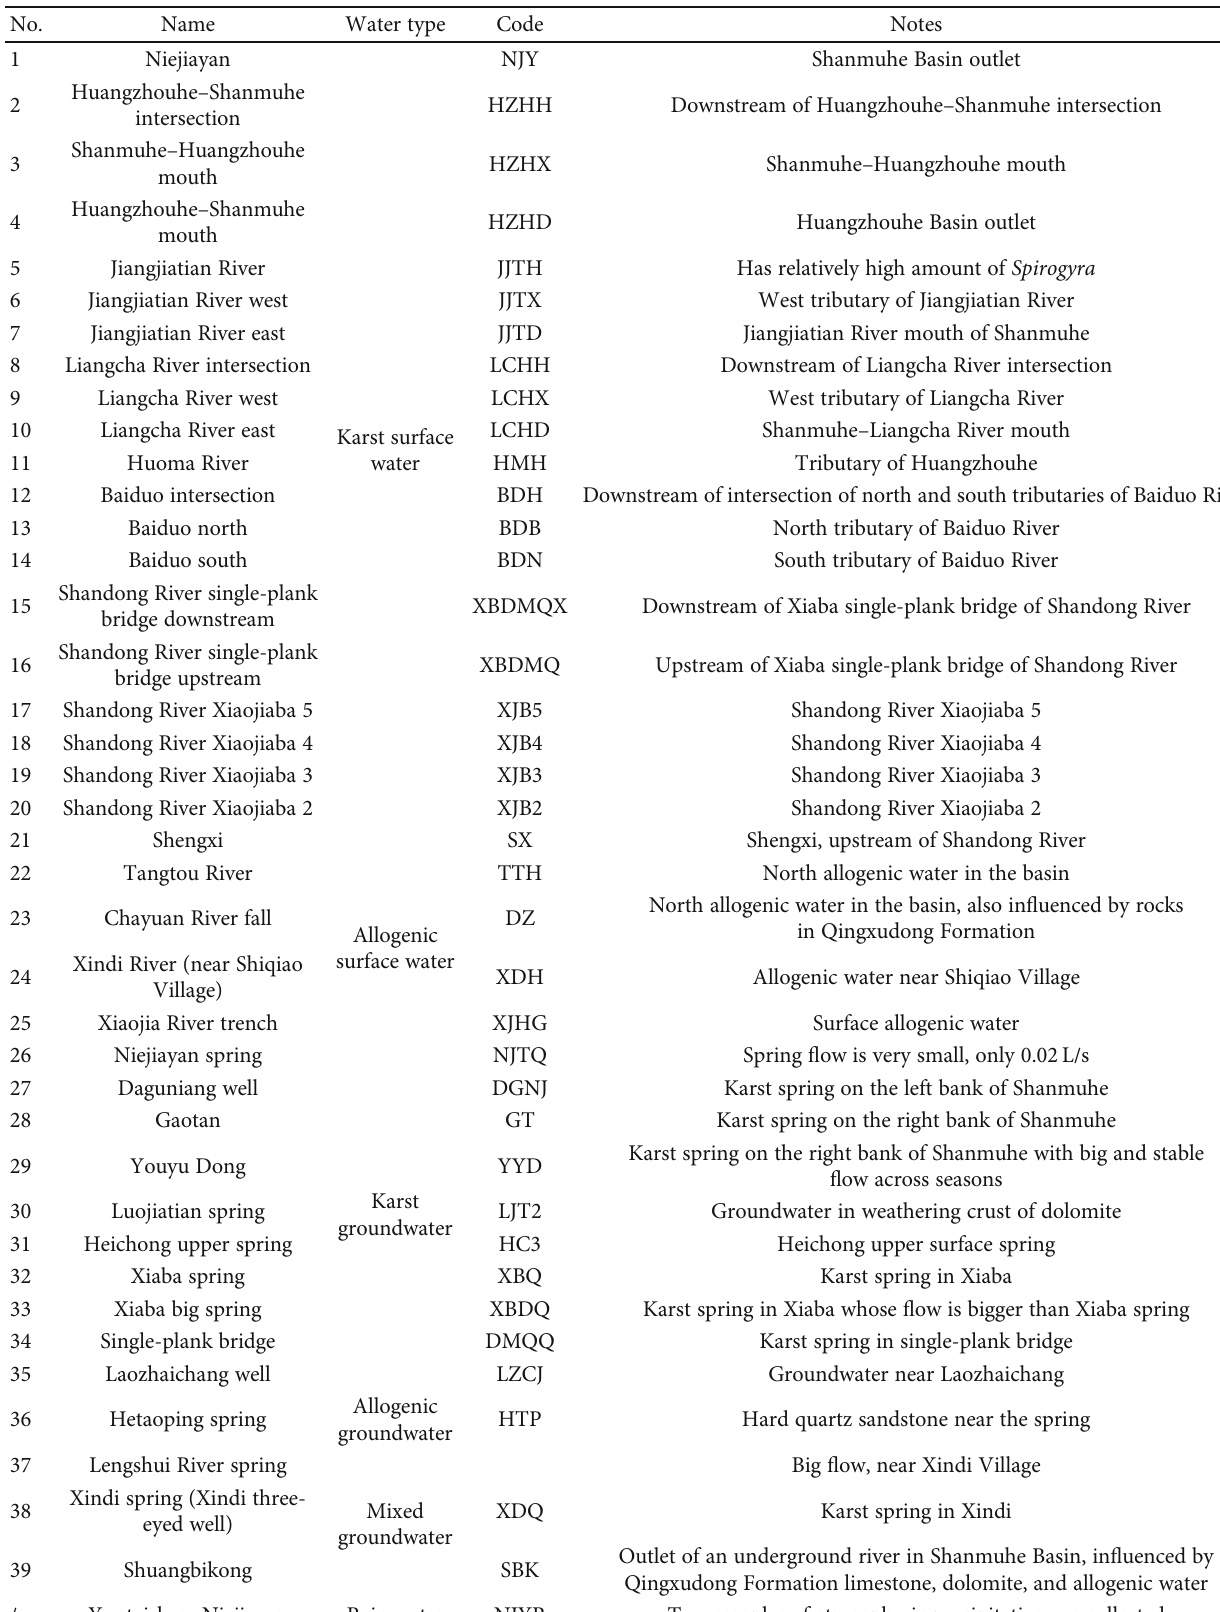
Table 1: Water samples collected in the study